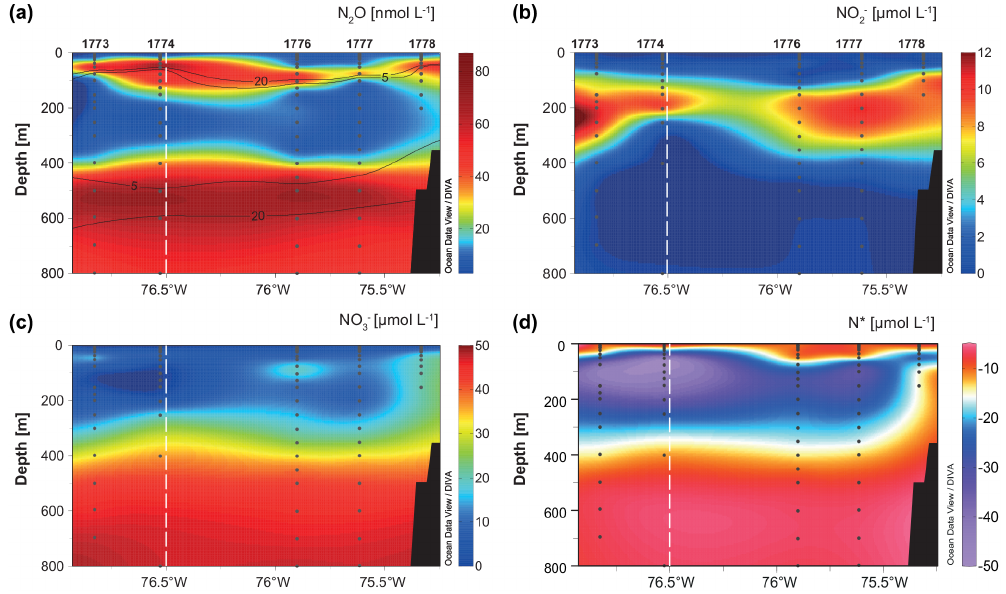
Figure 4. Cross-shelf distribution of N 2 O (a) , NO − (b) , NO − (c) , and N ∗ (d) along eddy A in December 2012 (16.2 ◦ S, 76.9 ◦ W to 15.3 ◦ S 2 3 75.2 ◦ W; see Fig. 1). Contours in (a) represent O 2 concentrations (in µmolL − 1 ) . The white dashed lines indicate the approximate location of the eddy centre according to SSHA data. Numbers above panels (a) and (b) are the station numbers (cf. Fig. 1).